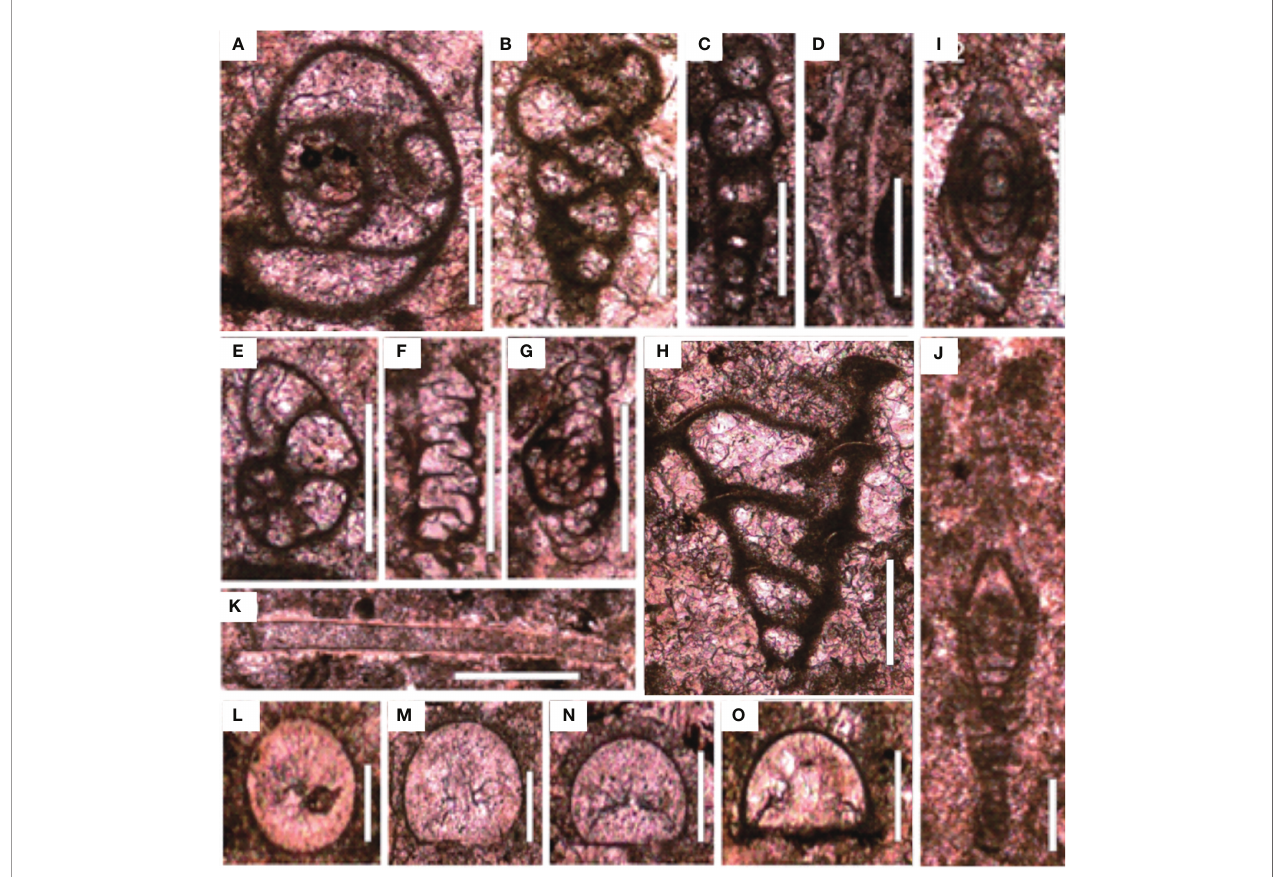
FIGURE 7 | Foraminifers from the Chibi section before the PTME. (A) Poatendothyra tenuis; (B) Dagmarita sp.; (C) Nodoinelloides neischajewi; (D) Rectocornuspira kalhori; (E) Globivalvulina sp.; (F) Ammovertella sp.; (G) Hemigordius sp.; (H) Dagmarita chanakchiensis; (I) Reichelina changhsingensis; (J) Reichelina matsushitai; (K) Earlandia sp.; (L – O) Diplosphaerina inarqualis. Scale bars in panels (A – K) are 100 m m in length and in panels (L – O) are 50 m